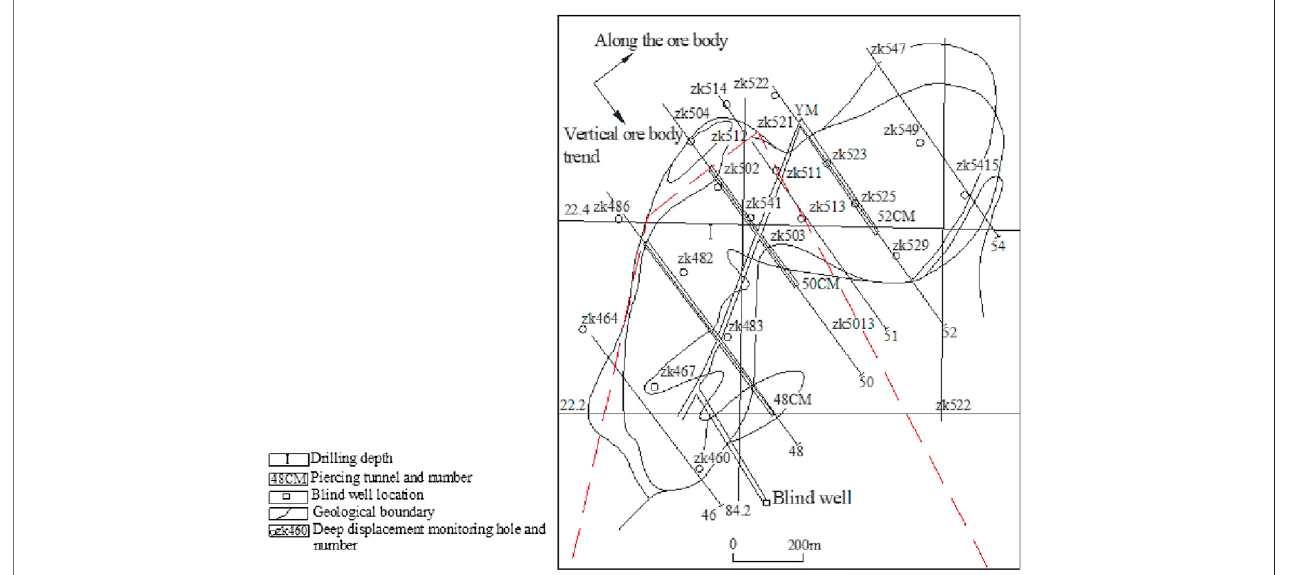
FIGURE 6 | Geological map of the 730 m middle section of the Dongguashan Copper Mine.